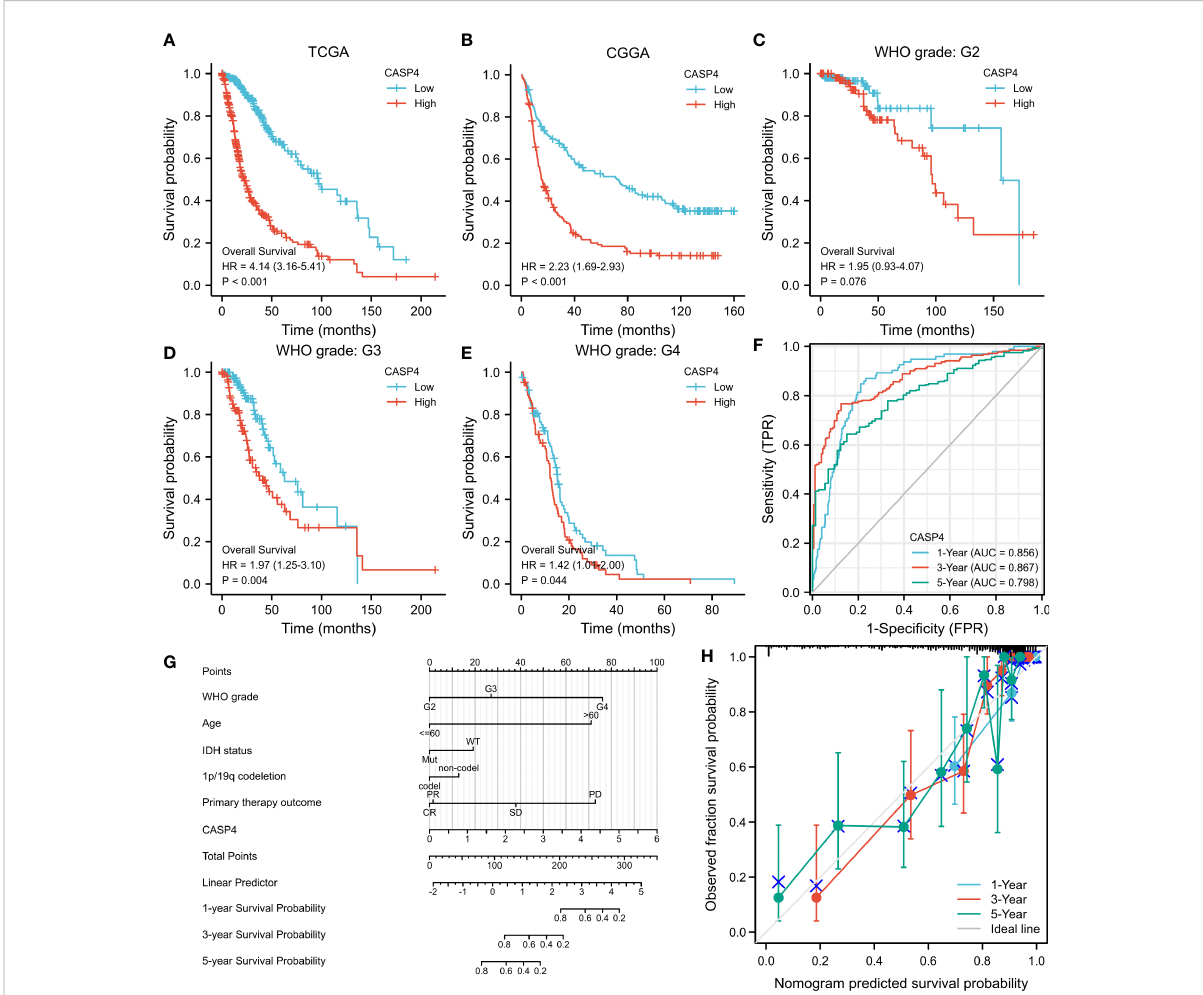
FIGURE 3 Survival curve, receiver operating characteristic (ROC) curve, and overall survival (OS) nomogram in The Cancer Genome Atlas (TCGA) database and Chinese Glioma Genome Atlas (CGGA) database suggest that high CASP4 expression is related to different disease states (tumor or normal) and overall survival. (A) Kaplan – Meier curves of OS in the training set (TCGA). (B) OS in the CGGA dataset. (C – E) OS by WHO grade in glioma patients in TCGA. (C) G2. (D) G3. (E) G4. (F) Time-dependent ROC curves for the 1-, 3-, and 5-year survival in TCGA cohort. (G) Nomogram for predicting the probability of 1-, 3-, and 5-year OS of glioma patients. (H) Calibration plot of the nomogram for predicting the probability of